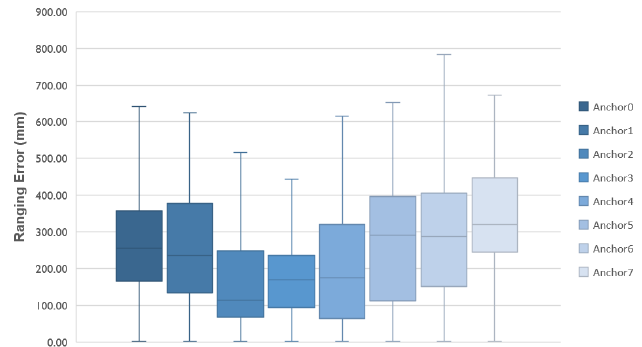
Figure 5. Average ranging error per anchor with the tag placed on the